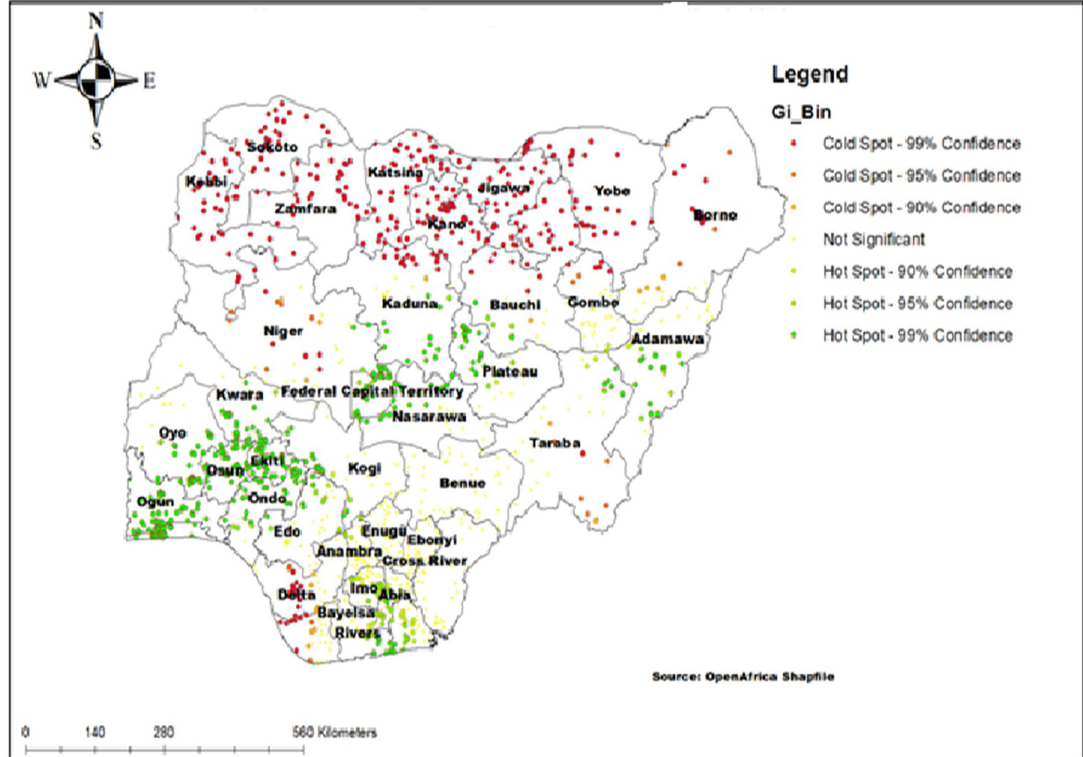
Fig 3. Hotspot analysis of modern contraceptive use in Nigeria,